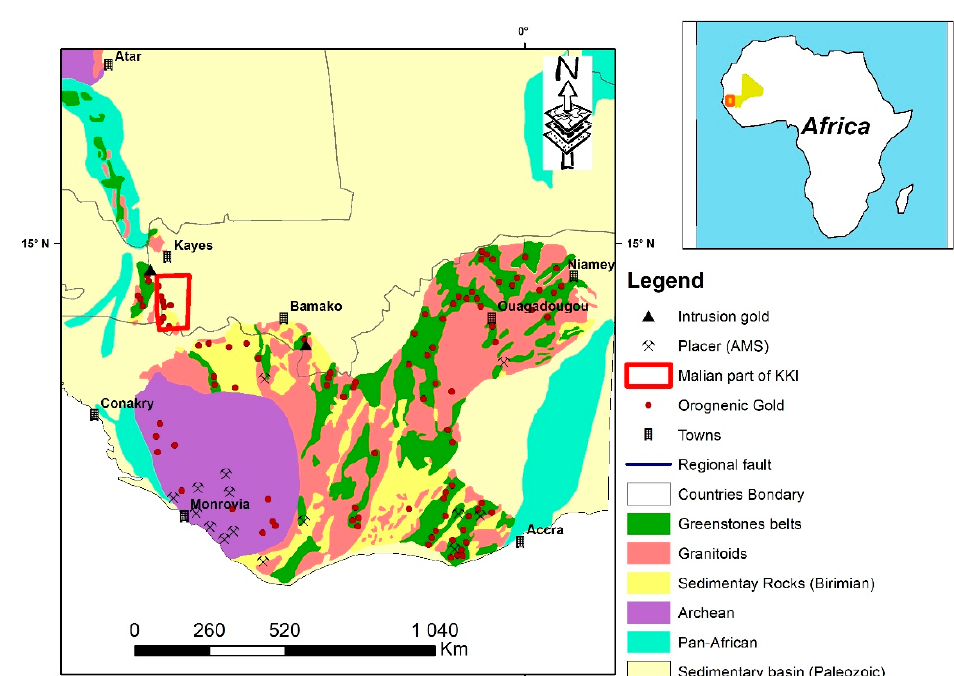
Figure 1. Geological map of West African Craton ([28], simplified).